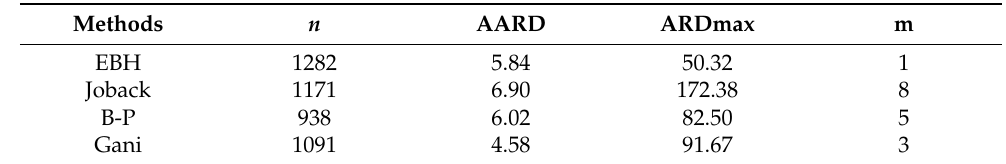
Table 7. Summary of estimation results of organic compounds evaporation enthalpy at normal boiling